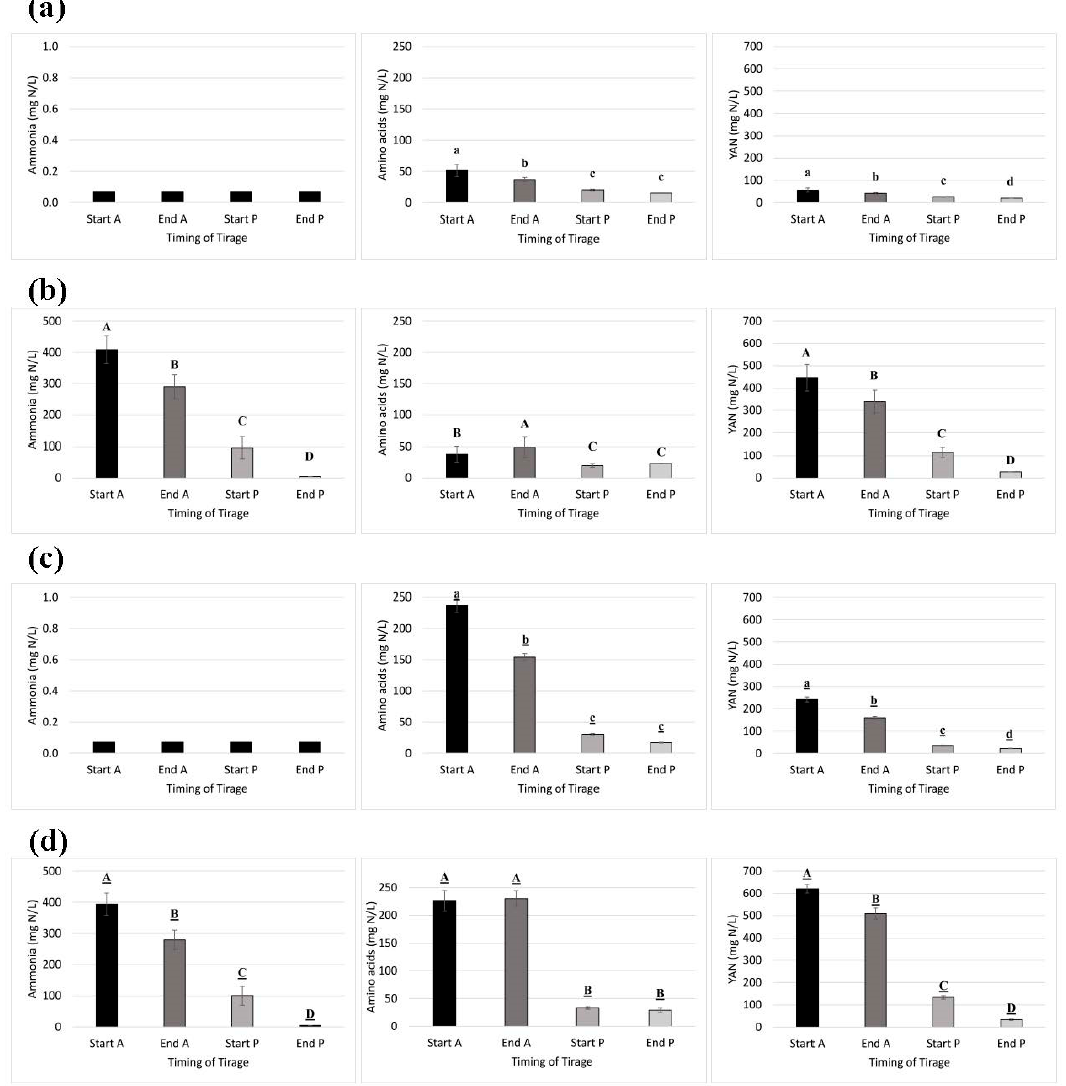
Figure 4. Nitrogen concentration during the stages of yeast acclimatization in the form of ammonia nitrogen ( column 1 ), amino acid nitrogen ( column 2 ) and Total YAN ( column 3 ), all reported as mg N / L. Nitrogen from ammonia and amino acids were determined at the start (Start A) and end (End A) of adaptation stage 2 and the start (Start P) and end (End P) of proliferation stage 3 for all four treatments. Total YAN is the addition of ammonia and amino acid nitrogen. Treatments were: T1 control, panel ( a ); T2 DAP addition, panel ( b ); T3 Go-Ferm ® addition, panel ( c ); and T4 DAP + Go-Ferm ® addition, panel ( d ). Due to low ammonia levels in T1 and T3, reported at the limit of detection of the kit (0.071 mg N / L), the Y-axis scale for ammonia was resized to range from 0 to 1 mg N / L for panel ( a ) and ( c ). All other scales were kept constant between treatments for comparison purposes. Di ff erent letters within a treatment for a given nitrogen source refers to significant di ff erences ( p < 0.05) in nitrogen concentration between time points as determined by ANOVA with mean separation by Fisher’s Protected (LSD0.05).